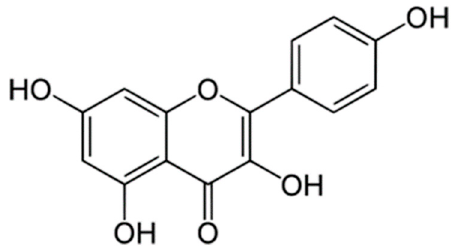
Figure 1. Chemical structure of kaempferol.